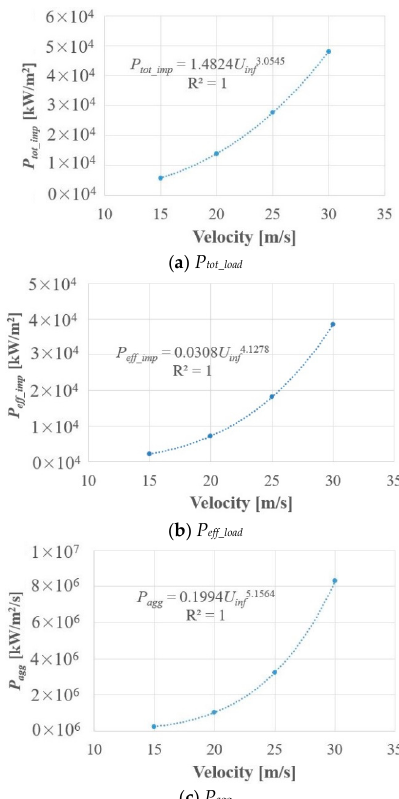
Figure 15. Predicted cavitation erosion intensity indicators at 40% of the chord as a function of flow velocity.